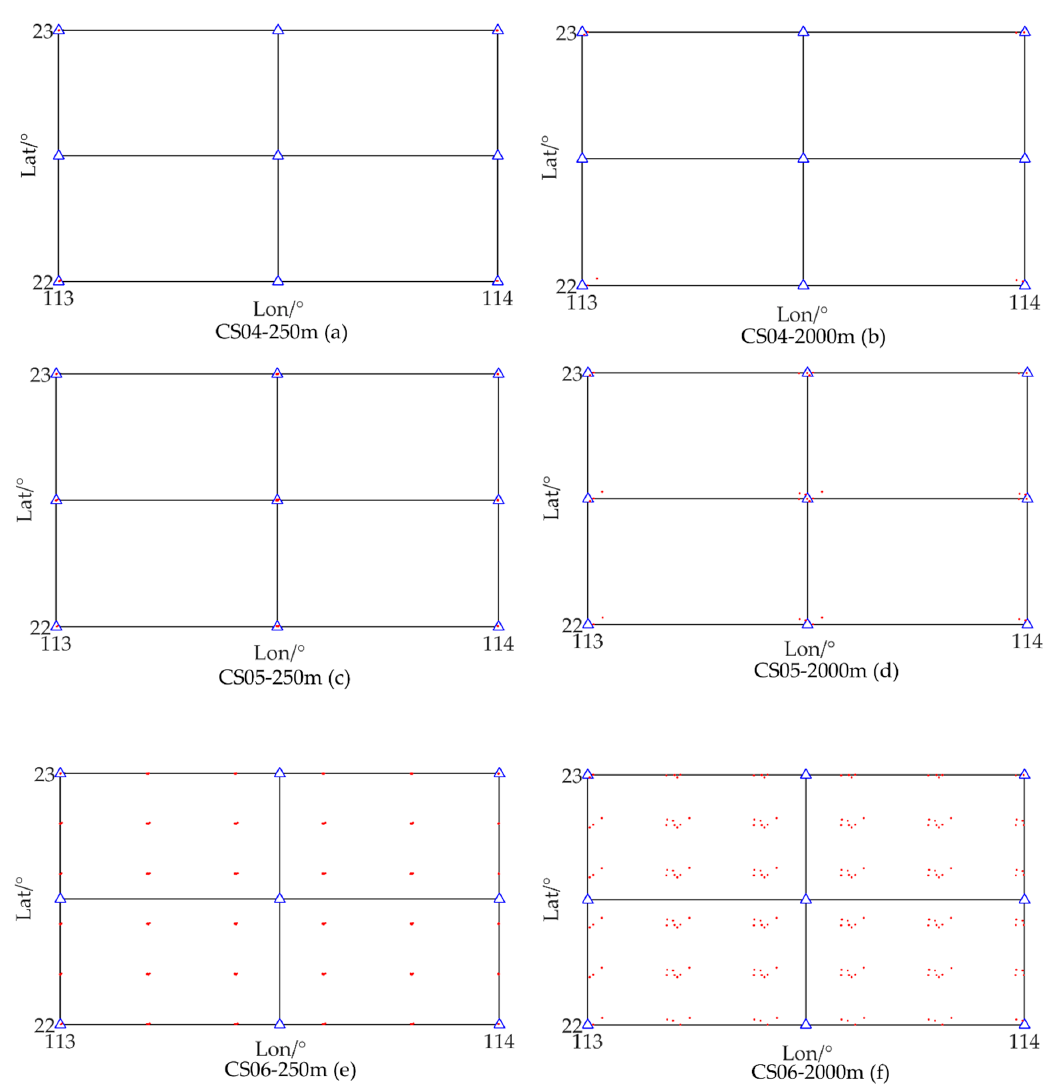
improvements of about 11.2 and 15% compared to CS04, respectively. At the middle layers, for